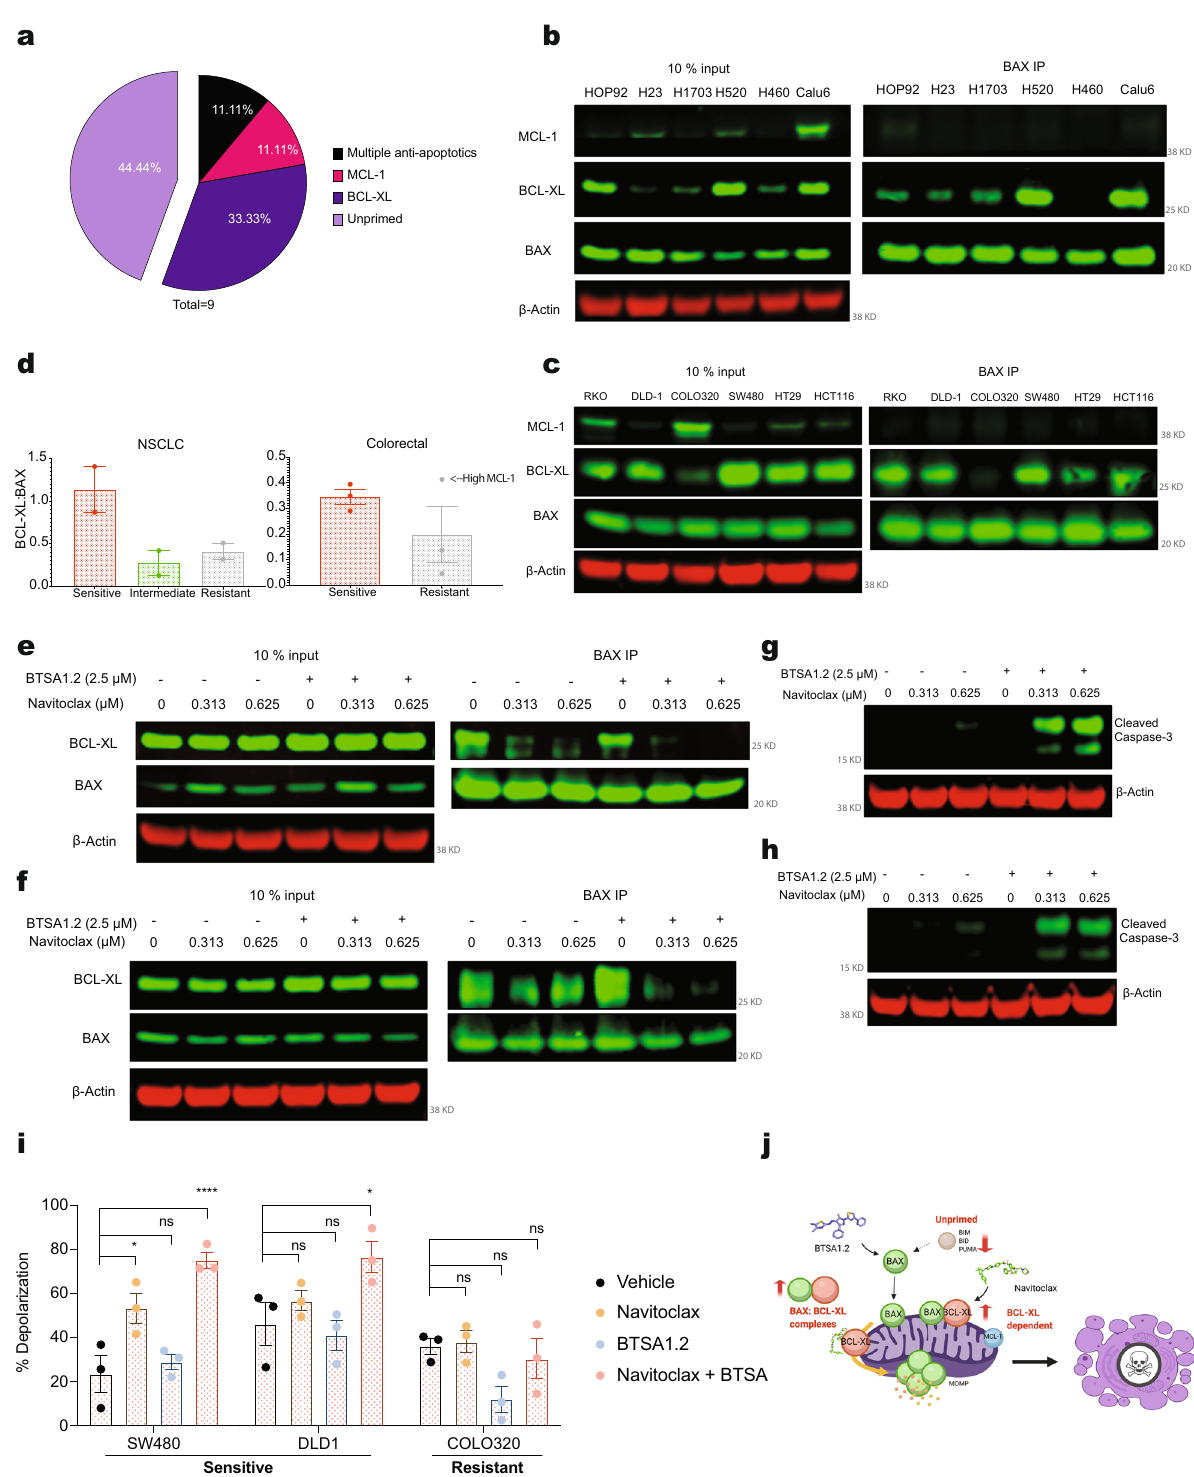
lymphocytes counts was observed after repeated dosing. Co- weight, red blood cells counts and organs examined were between administration of BTSA1.2 and Navitoclax was well tolerated and the normal parameters, lymphocytes, white blood cells and platelets counts reached levels below normal counts upon a single treatment with Navitoclax (Fig. 4b – g) as previously described 18,45,46 , and blood counts recovered to normal levels after treatment completion (Supplementary Fig. 12a – c). Upon BTSA1.2 treatment body weight and blood counts were measured in normal levels but reduction in white blood cells and NATURE COMMUNICATIONS| (2022) 13:1199